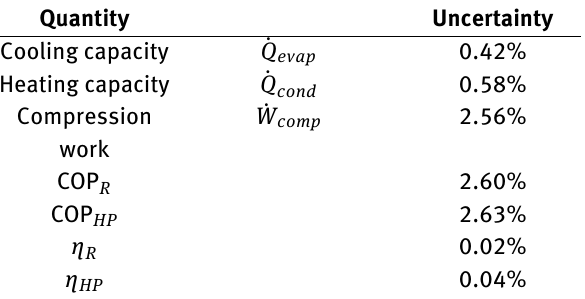
Table 6: Summary table with the uncertainty propagation to all the derived